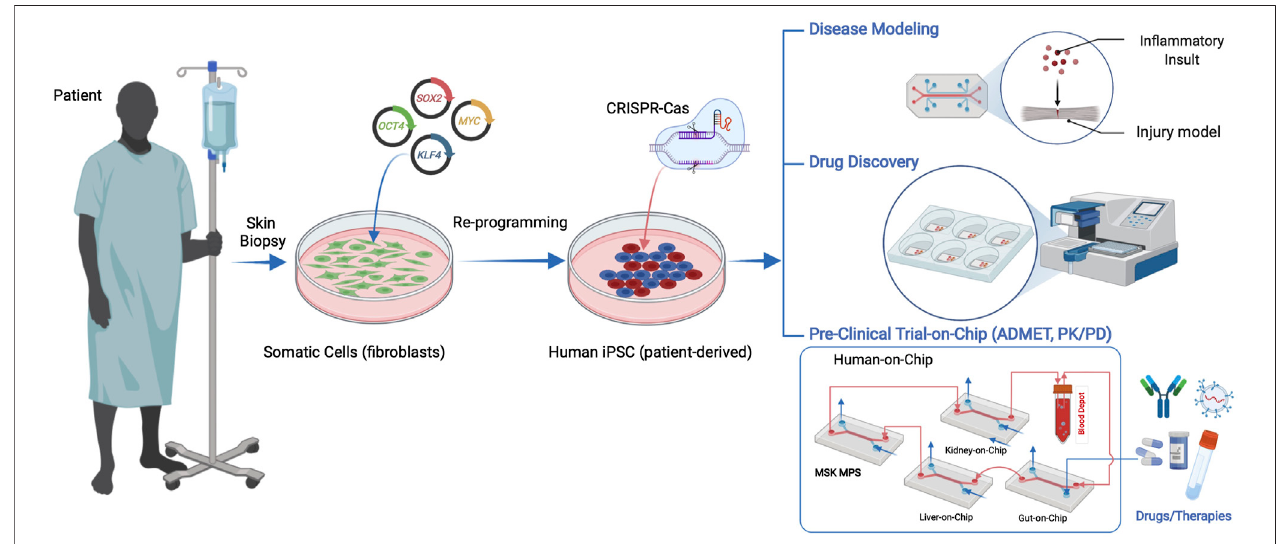
FIGURE 1 | Human iPSCs can be derived from patient somatic cells procured through a minimally invasive tissue biopsy and reprogramming using pluripotency factors.hiPSCapplicationsinmicrophysiologicalsystemsincludediseasemodels,drugdiscovery,andhumanpreclinicaltrialsonachip,includingADMET(absorbance, distribution, metabolism, excretion, and toxicity) and pharmacokinetics and pharmacodynamics (PK/PD) studies.